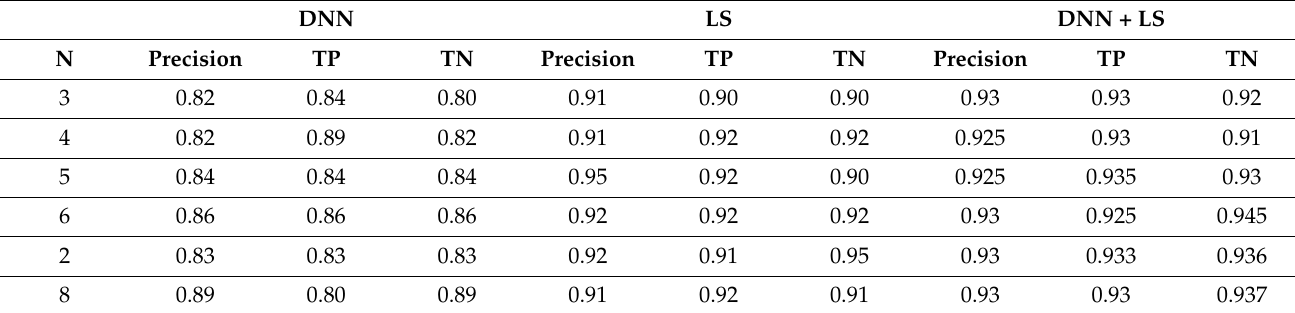
Table 7. Comparison of performance results with different numbers of clusters from the C-Means (N) for the SV-S2017